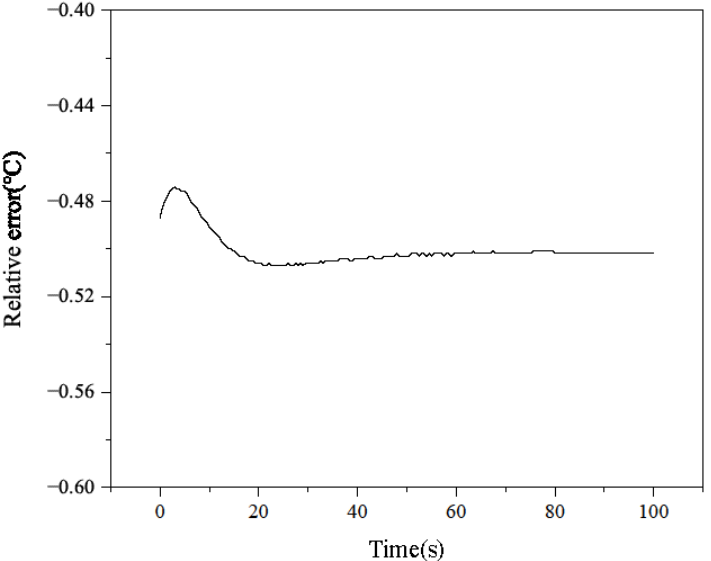
Figure 11. The relative error between the backward equation method and the original method of a 2% step increase in inlet water temperature.